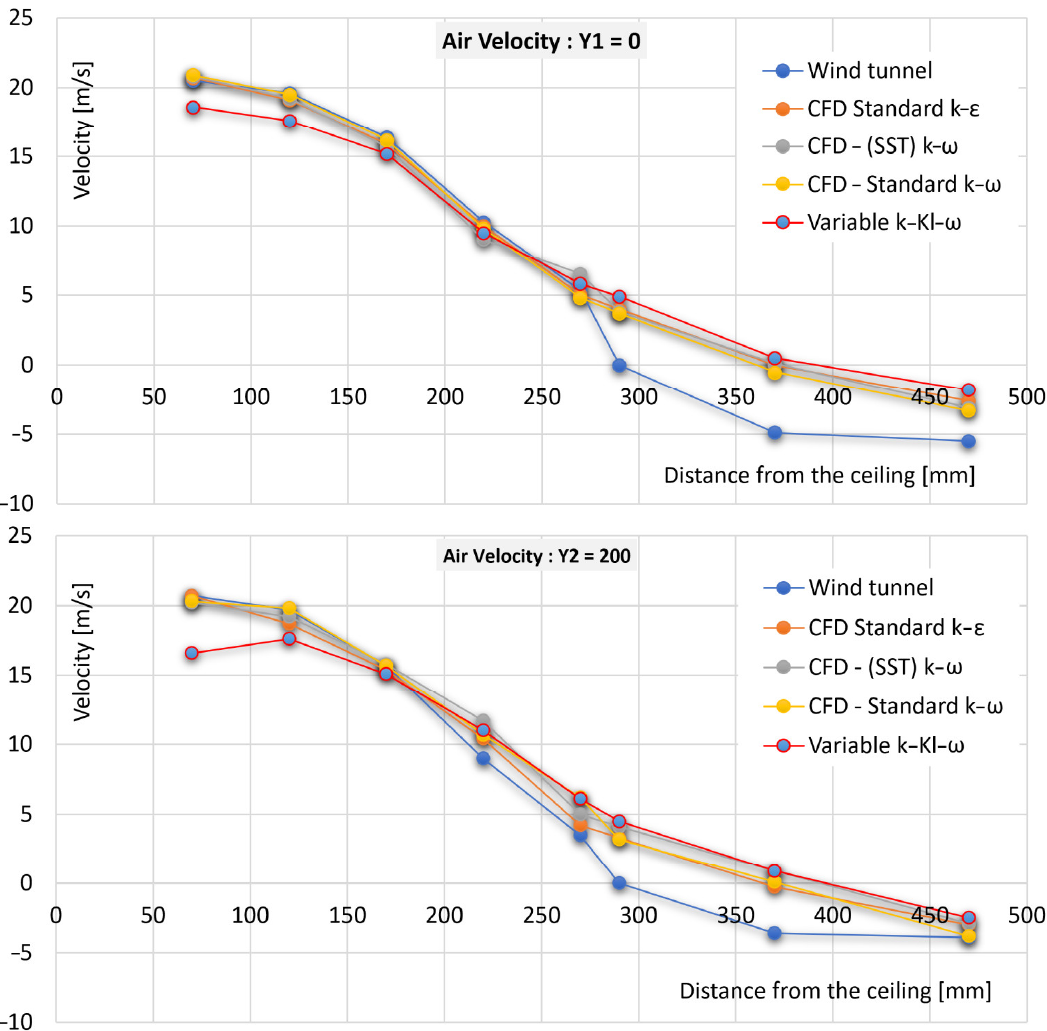
Figure 9. Air velocity at measuring area T2 (downstream of the model), at Y = 0 (centerline) and Y = 200 mm; beam size of 288 mm; average inlet velocity of 7.9 m/s.